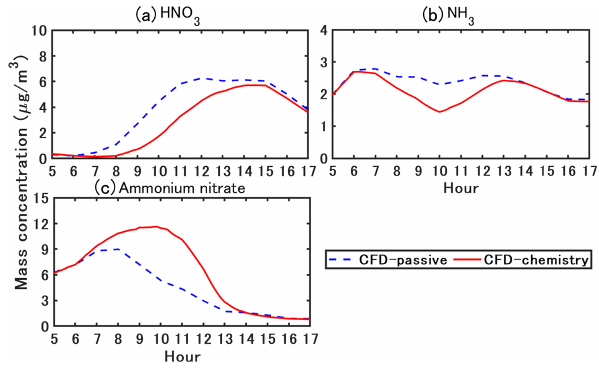
Figure 14. Simulated time-varying concentrations of ammonium nitrate and precursor gas (HNO 3 and NH 3